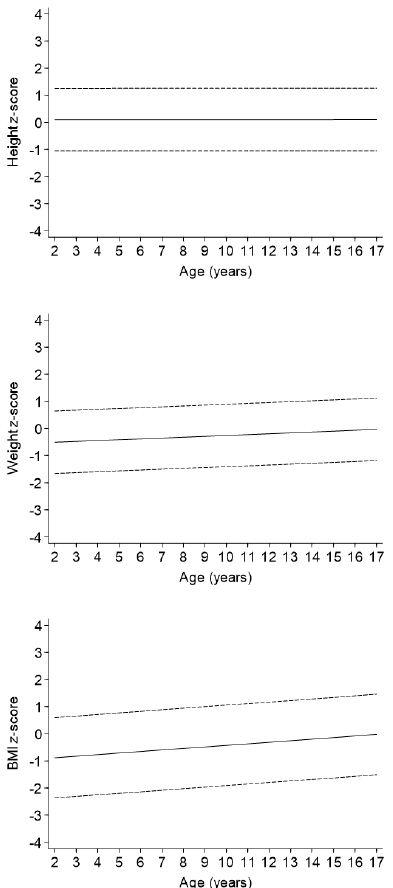
Figure 2. Change in height, weight, and BMI z-scores levels with age.